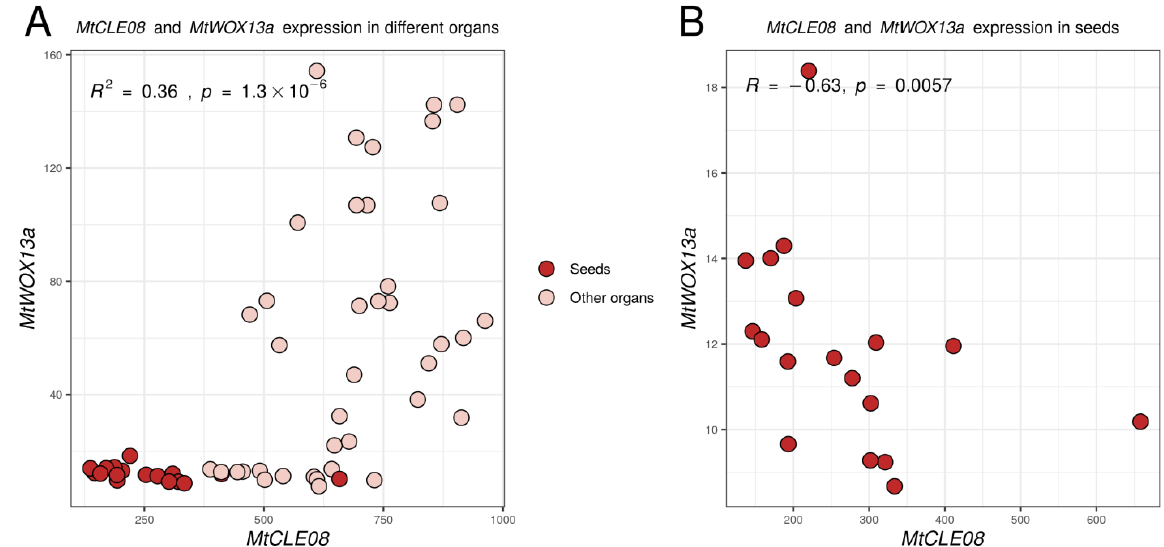
Figure 7. Expression levels of the MtWOX13a and MtCLE08 genes in different organs and during different stages of seed development according to the Medicago truncatula Gene Expression Atlas [21]. To assess the statistical significance of correlation between expression levels of different genes, Spearman’s rank correlation test was used.